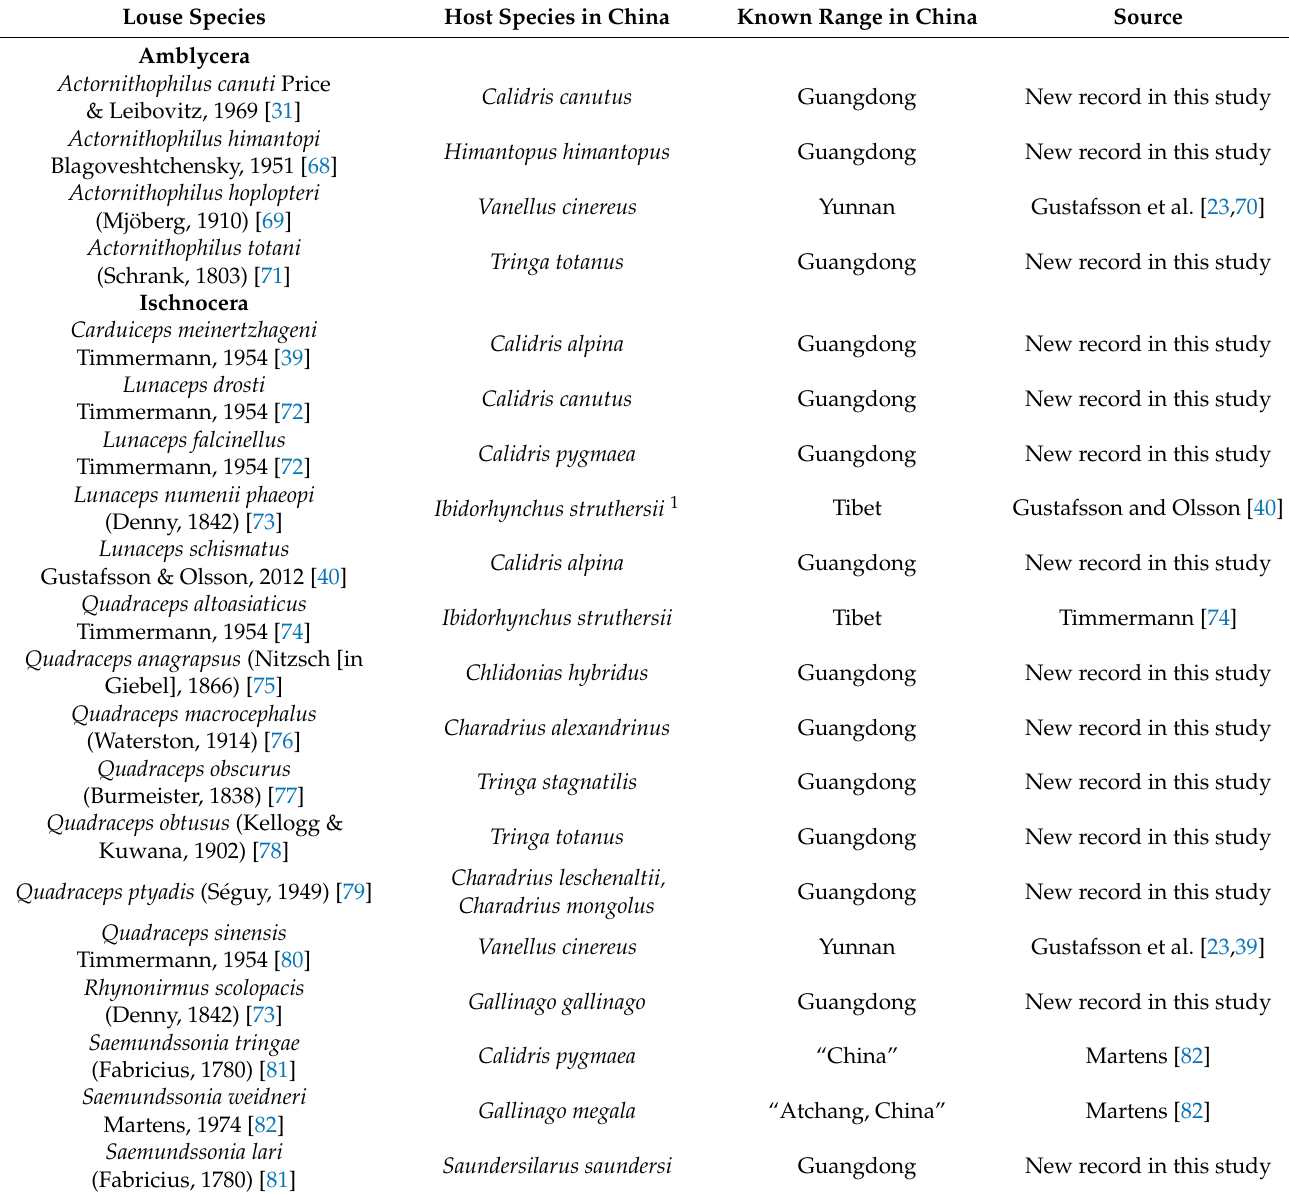
Table 3. Checklist of known shorebird lice from China. Gustafsson and Olsson [40] reported Lunaceps limosae Bechet, 1968 [67], from “[China?], Tonghoo”, but this locality is likely referring to Taungu, which is in Myanmar. No further reports of L. limosae from China have been published, and the species is not included